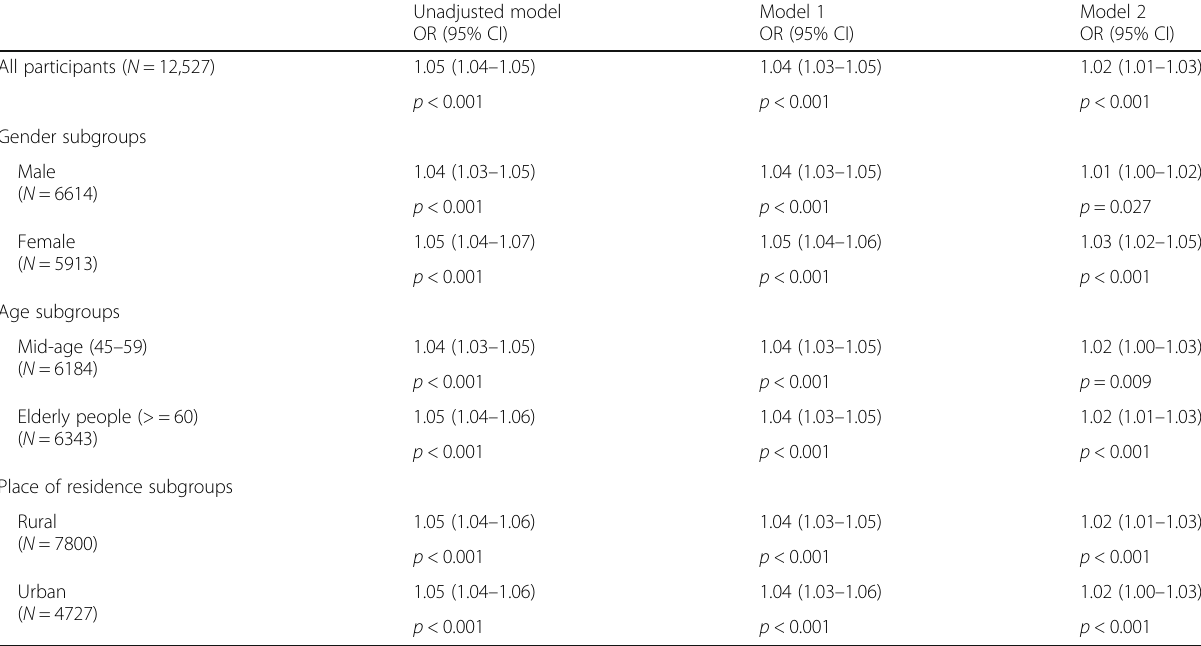
Table 3 Logistic regression analysis of depressive symptoms (CES-D score as continuous variable) and subsequent fall accidents among